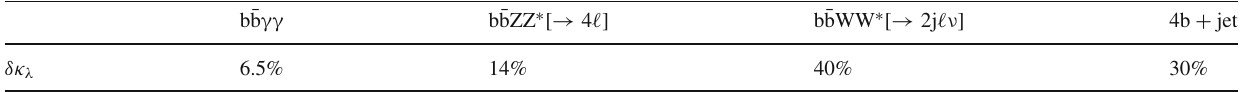
Table 10.2 Precision of the direct Higgs self-coupling measurement in gg → HH production, for various decay modes, from the FCC-hh detector performance studies